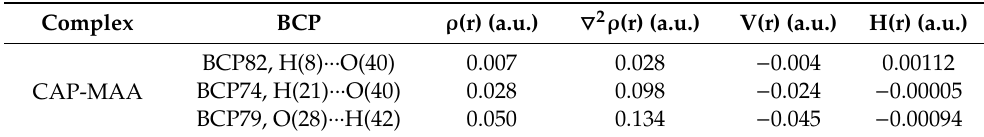
Figure 5. Topological atoms in molecules (AIM) graph of the CAP–MAA complex. Table 2. Electron and energy densities of the CAP–MAA complex at the hydrogen bond critical points